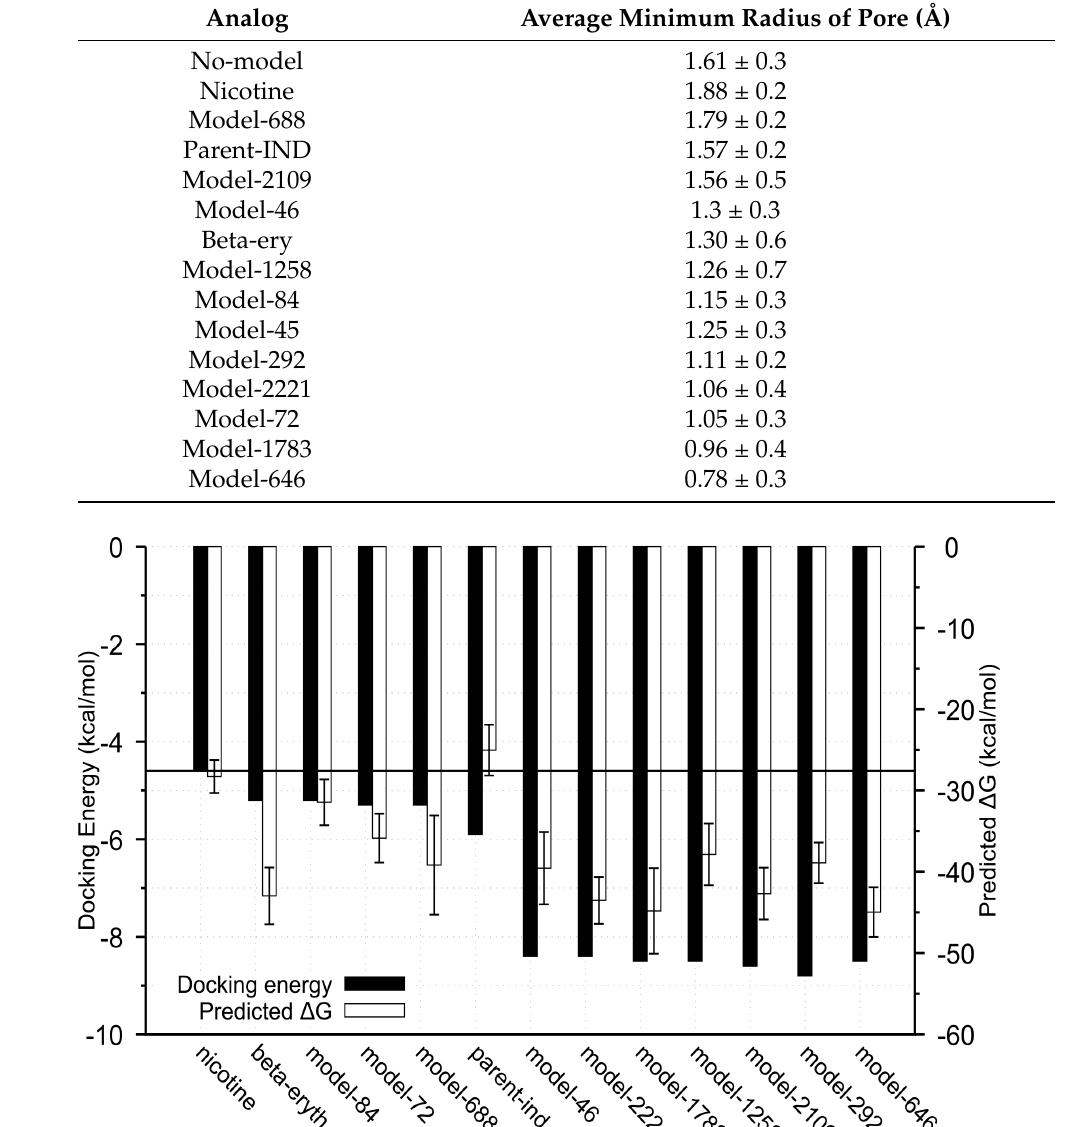
Table 3. Average minimum radius of ion channel pore for last 50 ns of simulation.